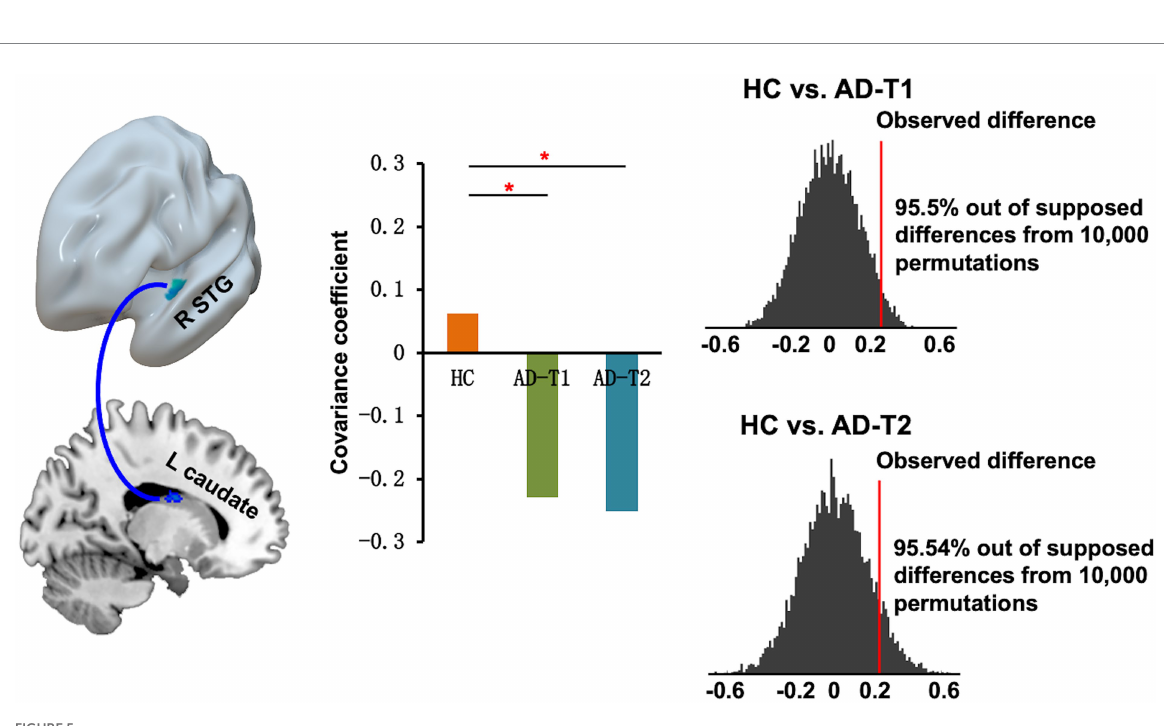
FIGURE 5 Decreased structural covariance connectivity between right STG and left caudate in AD patients at both time points as compared to HC. The permutation tests demonstrated that the between-group difference in the real covariance connectivity was out of 95% (two-tailed) of the supposed between-group differences. The red lines indicate observed difference in the strength of correlations between STG volume and left caudate volume for HC vs. AD-T1 and HC vs. AD-T2. * p <